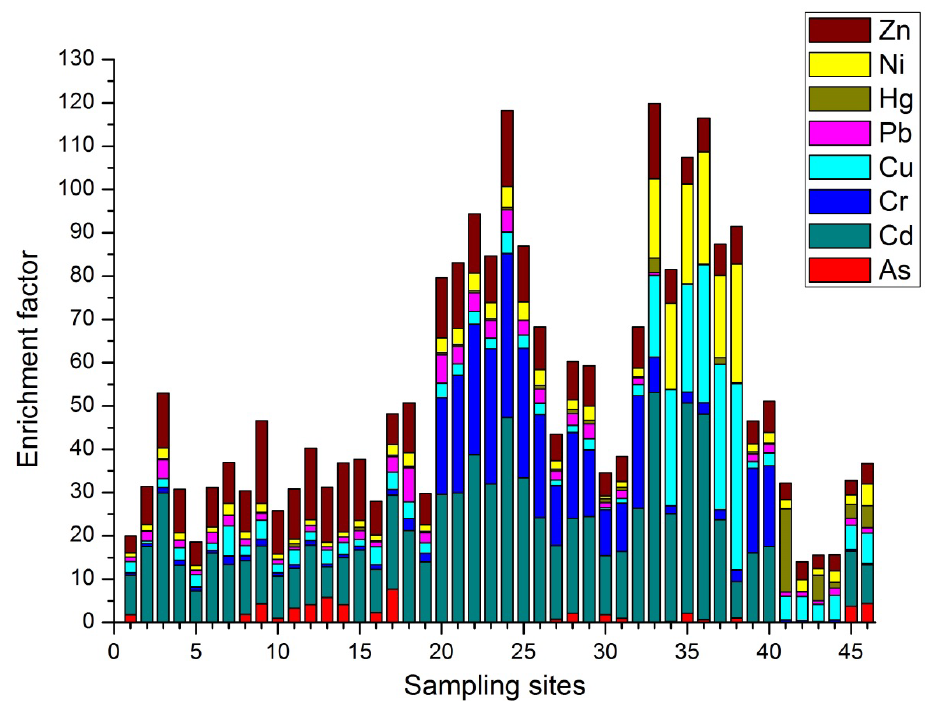
Figure 2. Enrichment factor (EF) values of heavy metals at each sampling site.